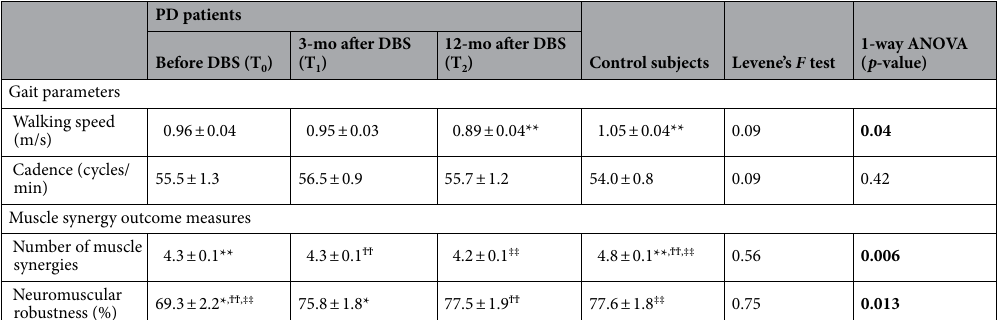
Table 1. Demographic and anthropometric characteristics of PD and healthy populations. Parameters’ values are reported as mean ± standard error over the sample population. M males, F females, UPDRS - III unified Parkinson’s disease rating motor subscale, H&Y Hoehn and Yahr scale, N/A not applicable or not assessed. Statistically significant differences are represented through asterisks (*** p < 0.001).